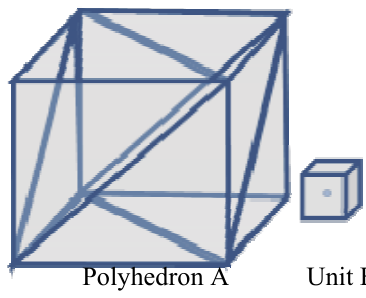
Figure 6. Polyhedron-inner side evaluation for point by using the triangle